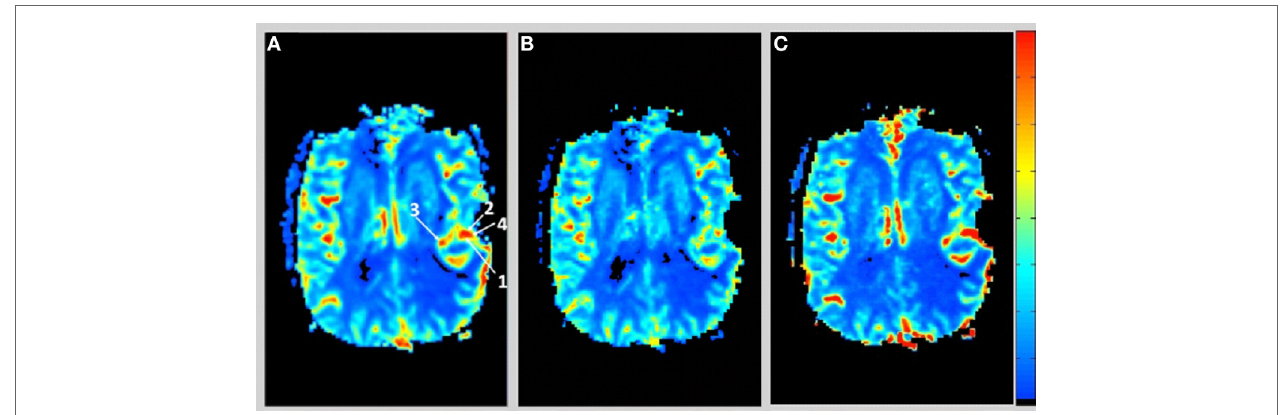
FigUre 1 | (a) Relative cerebral blood volume map generated from the leakage corrected data, (B) relative cerebral blood flow map determined by the peak of the first-pass tissue residue function, and (c) relative cerebral blood flow map determined by the peak of the second-pass tissue residue function. Note the tight coupling between blood volume and blood